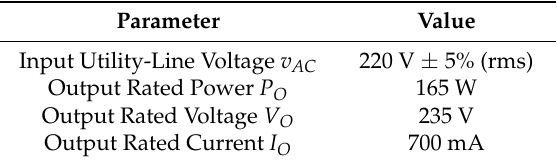
Table 1. Specifications of the presented single-stage LED driver.